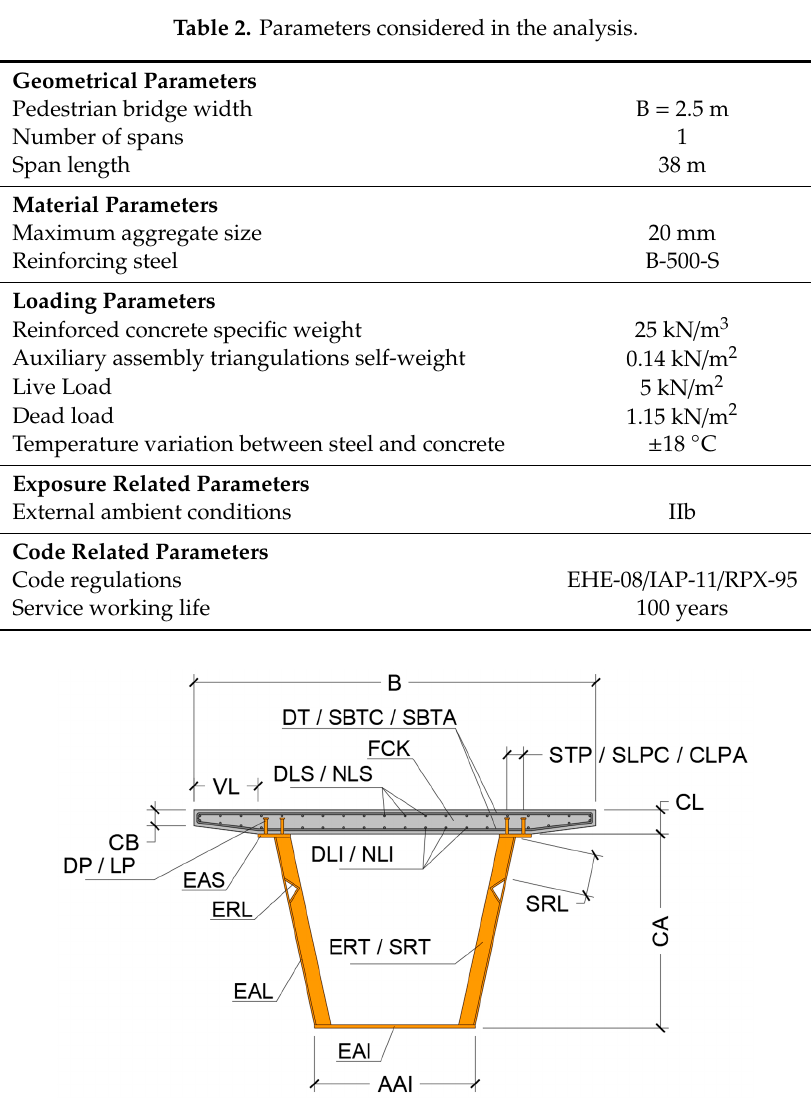
Figure 1. Box-girder geometrical variables and reinforcement. Table 3. Box-girder geometrical variables description and values range